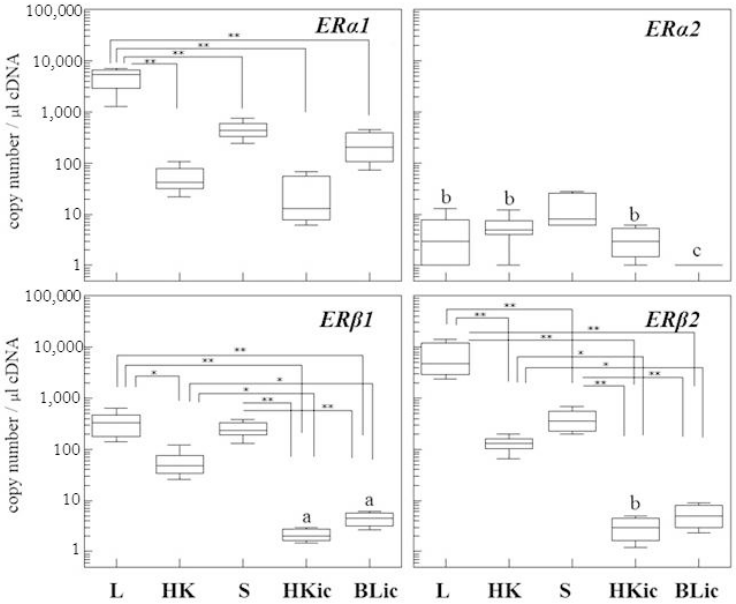
Figure 1. Absolute mRNA quantification of the four estrogen receptor (ER) isoforms in liver (L), head kidney (HK), spleen (S) and immune cells isolated from either head kidney (HKic) or blood (BLic) of 6-month-old female rainbow trout. The gene copy number of each isoform per 1 µL cDNA is presented by Box-Whisker plots ( n = 5 individuals). Note logarithmic scale of y-axis. * p < 0.05, ** p < 0.01. a: under detection limit. b: Part of the sample was not detectable or under detection limit. c: not detected.